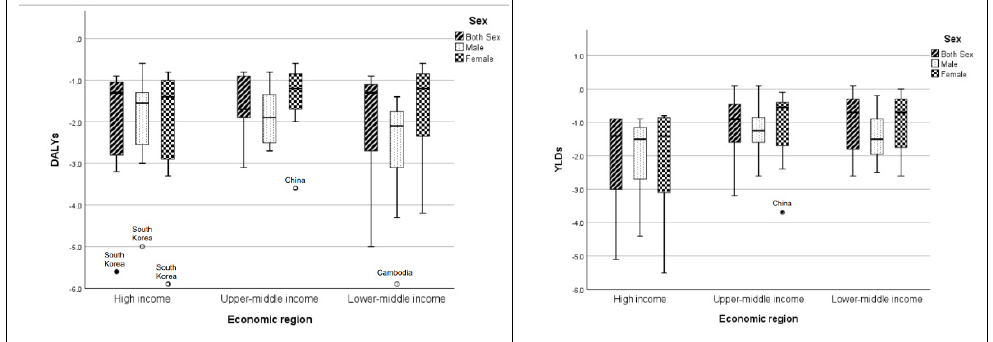
Figure 2. Boxplots of the average annual percentage change in age-standardized DALYs and YLDs rates attributable to nutritional deficiency among older adults (65+) from 1990 to 2019 in the Western Pacific region.